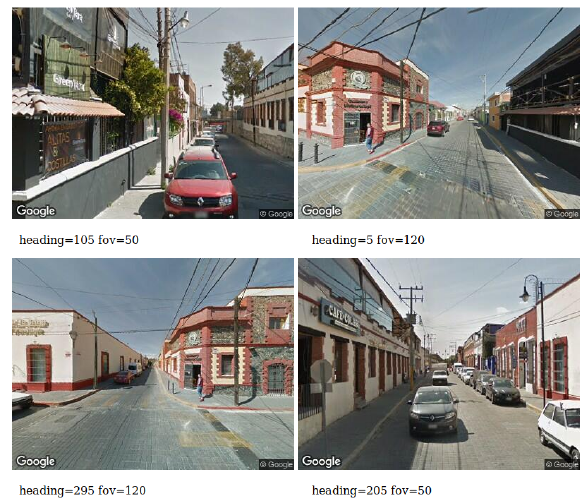
Figure 3. Four different images from one hotspot. Heading and fov are two parameters used to configure the resulted image from de Street View Static